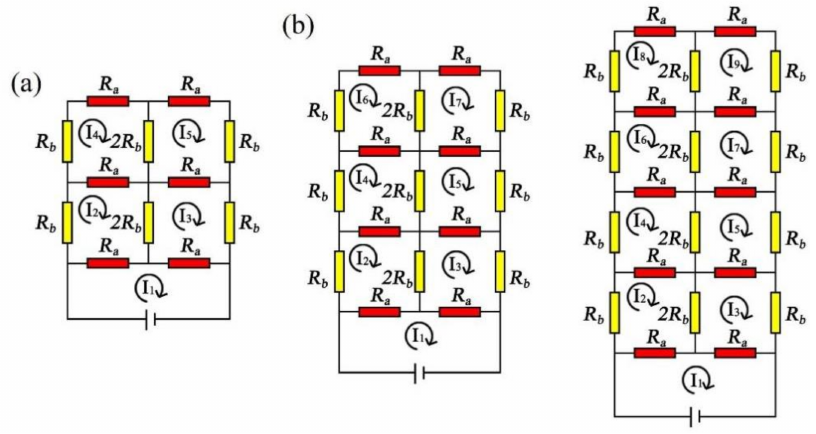
Figure 5. ( a ) 2 courses × 2 wales loop circuit; ( b ) 3 courses × 2 wales and 4 courses × 2 wales loop